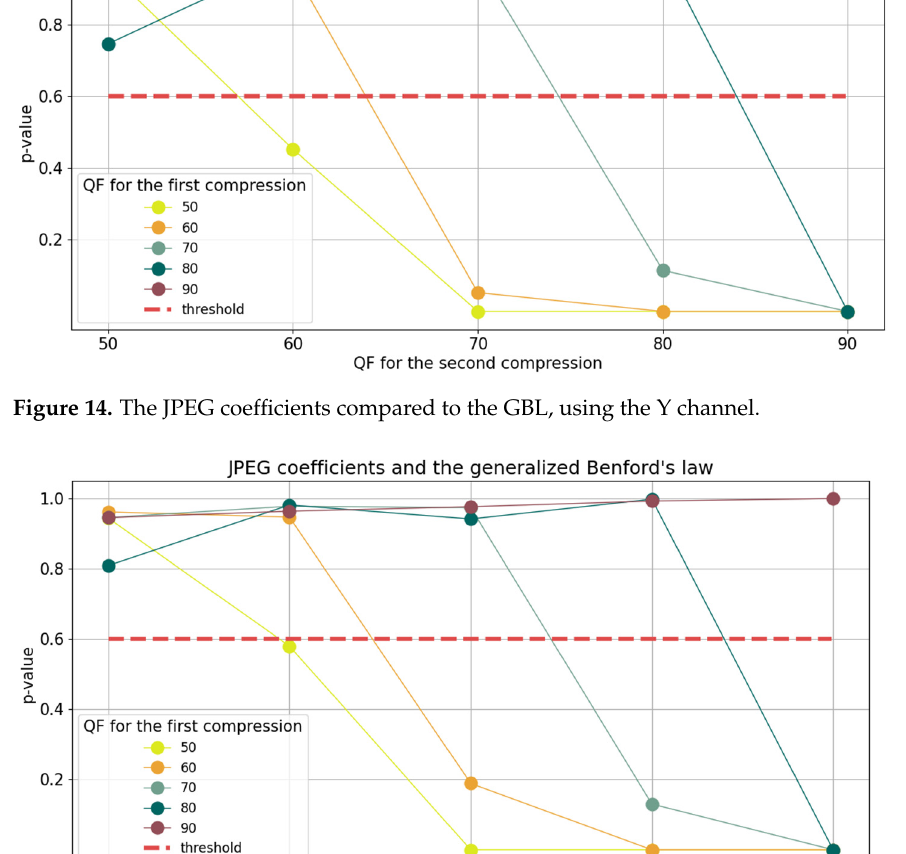
Figure 15. The JPEG coefficients compared to the GBL, using the R channel.